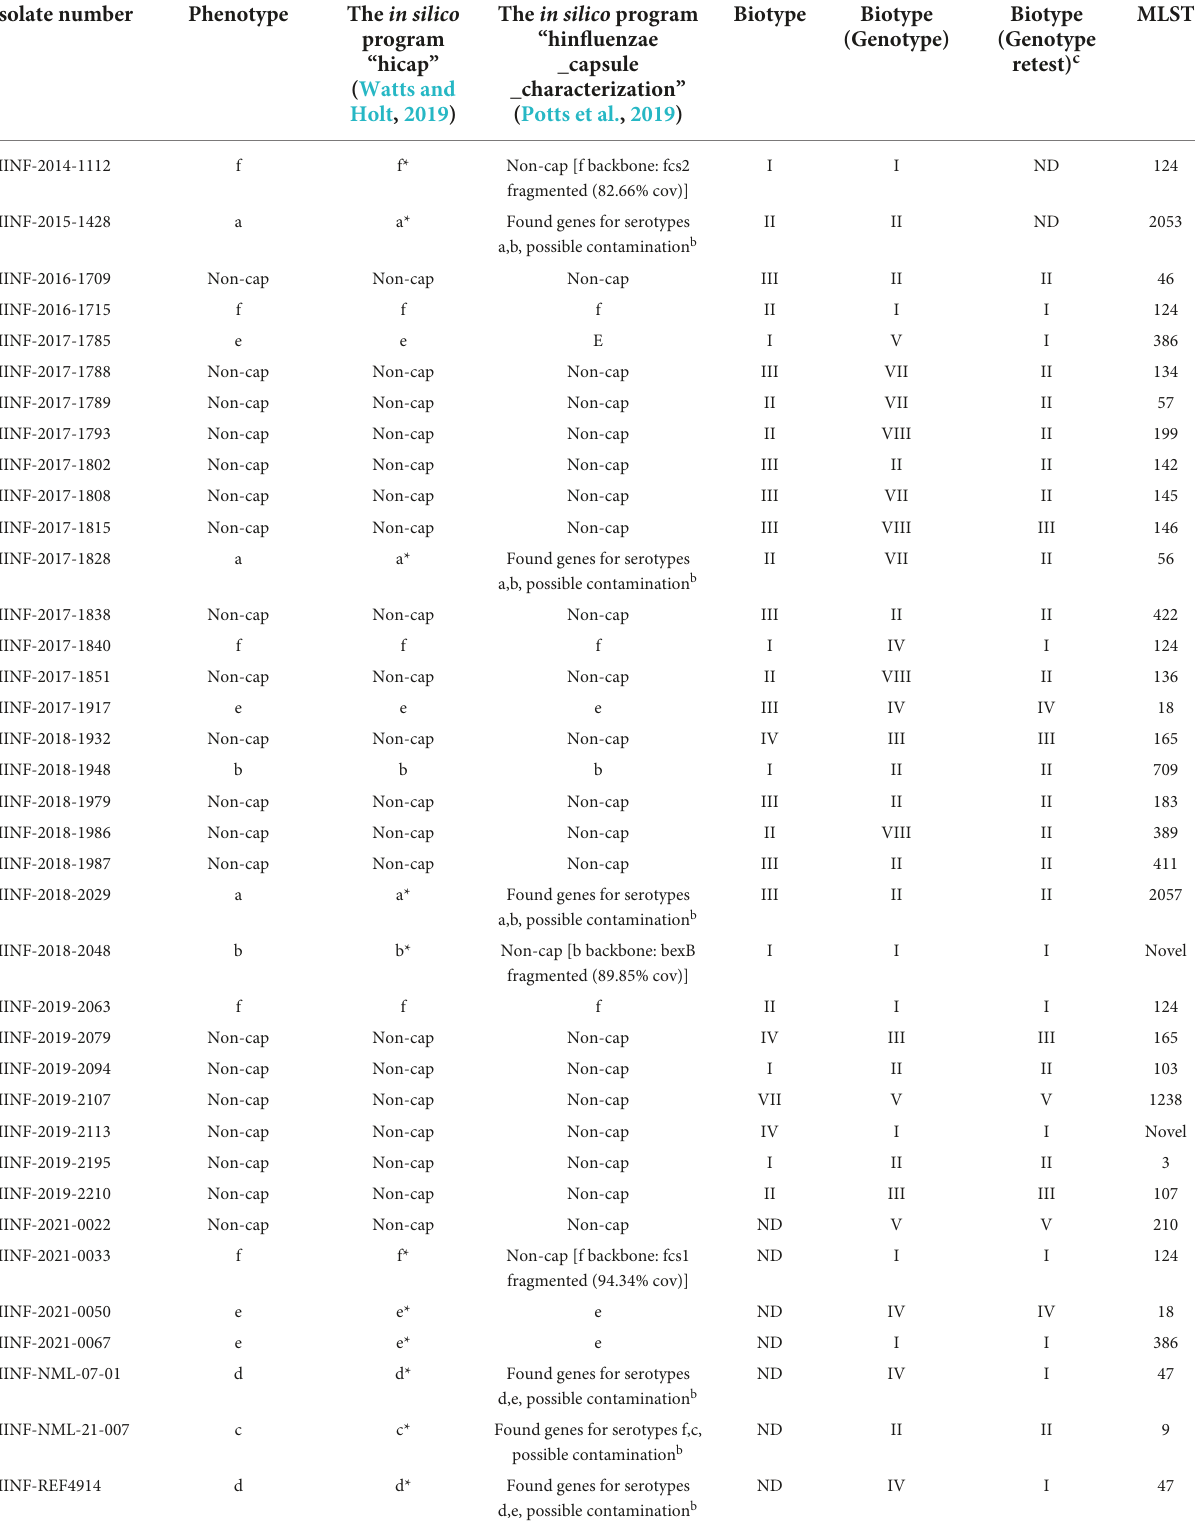
TABLE 1 List of isolates with divergent phenotype/genotype for serotype or biotype and missing values. Isolate